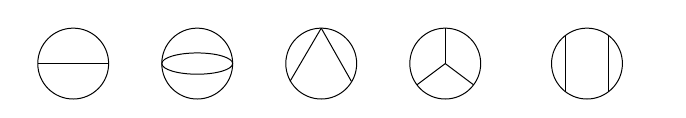
Figure 5 . Type of UV finite diagrams that mutually cancel at order O ( β 4 ) .